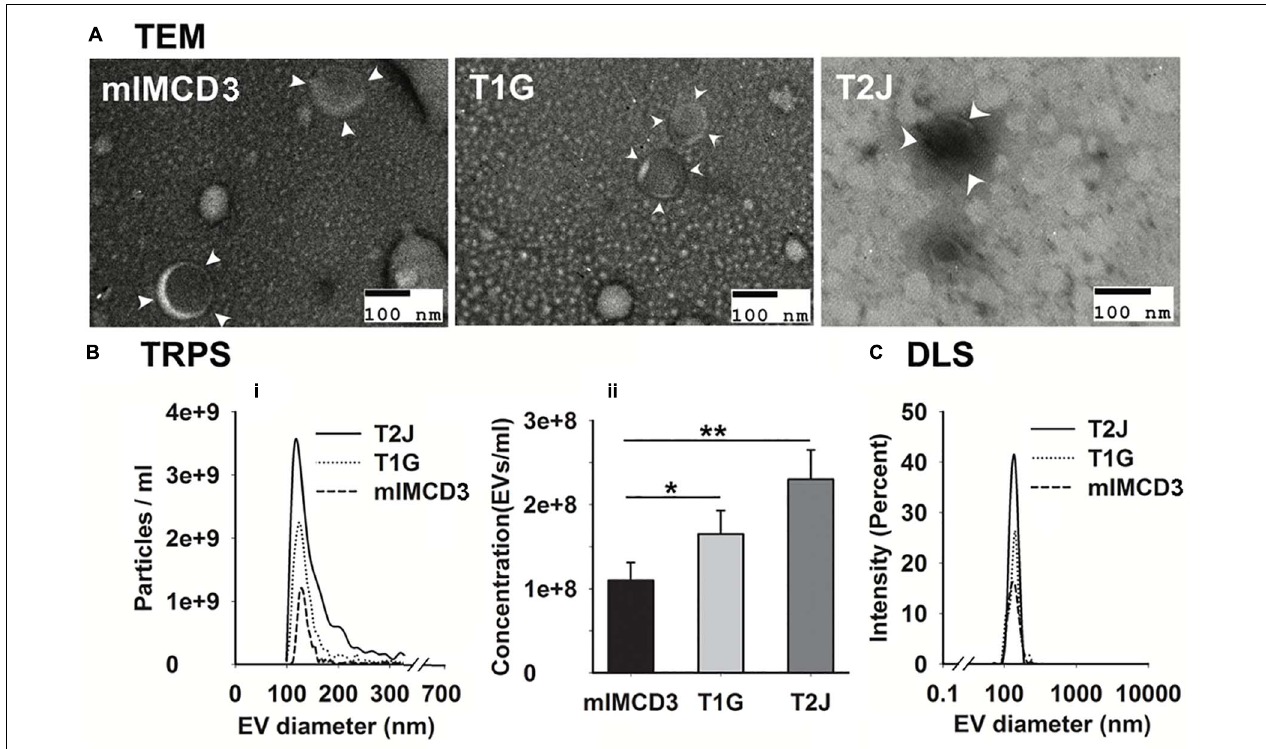
FIGURE 1 | Characterization of mIMCD3, T1G, and T2J cells derived EVs. (A) Representation of transmission electron microscopy confirmed the rounded cup-shaped structure of EVs (indicated with white arrowhead) isolated from the cell culture media of all three cell lines (scale bar 100 nm). (B-i,ii,C) Tunable resistive pulse sensing (TRPS) and dynamic light scattering (DLS) analysis of purified EVs. Data ( n = 3 ) were represented as mean ± SD. *Significant difference analyzed by t -test (* p < 0.05, ** p <